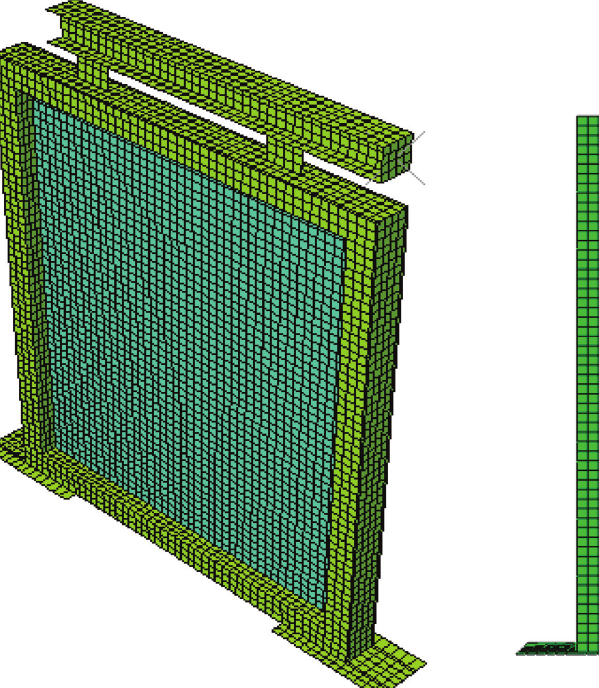
Figure 8: Numerical model meshing.